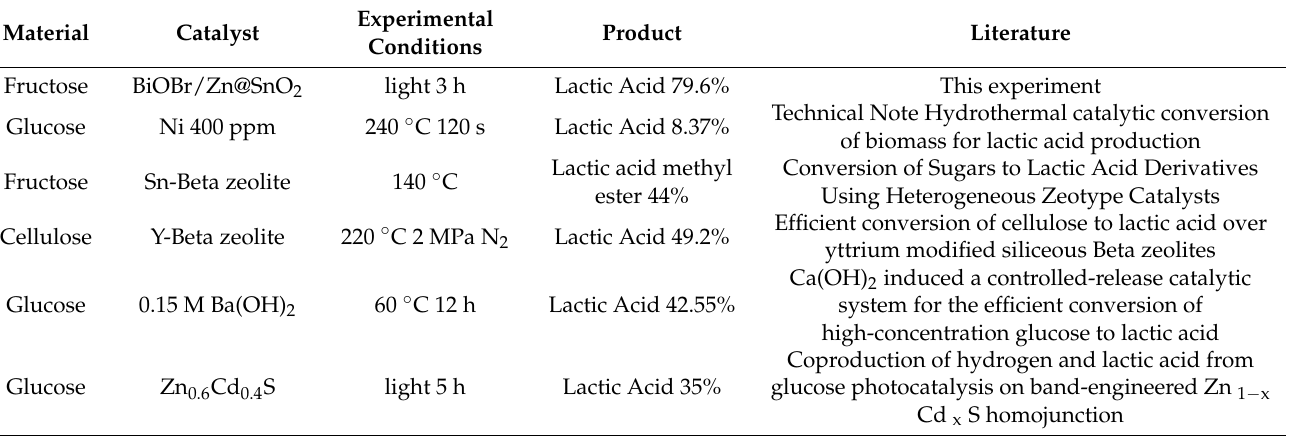
Table 2. Comparison of this experiment with previous